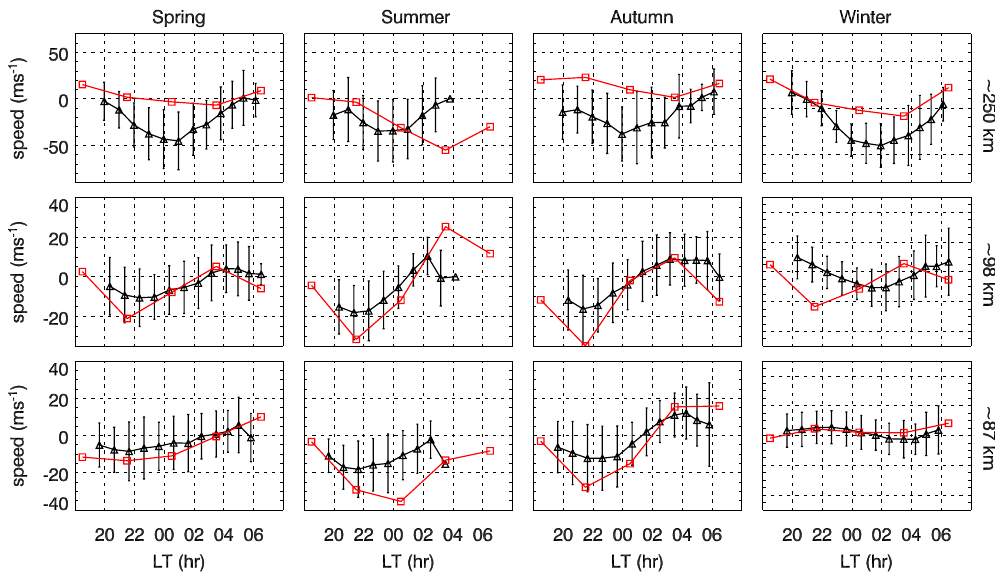
Fig. 8. Same as Fig. 6 but for the meridional (northward positive) wind.